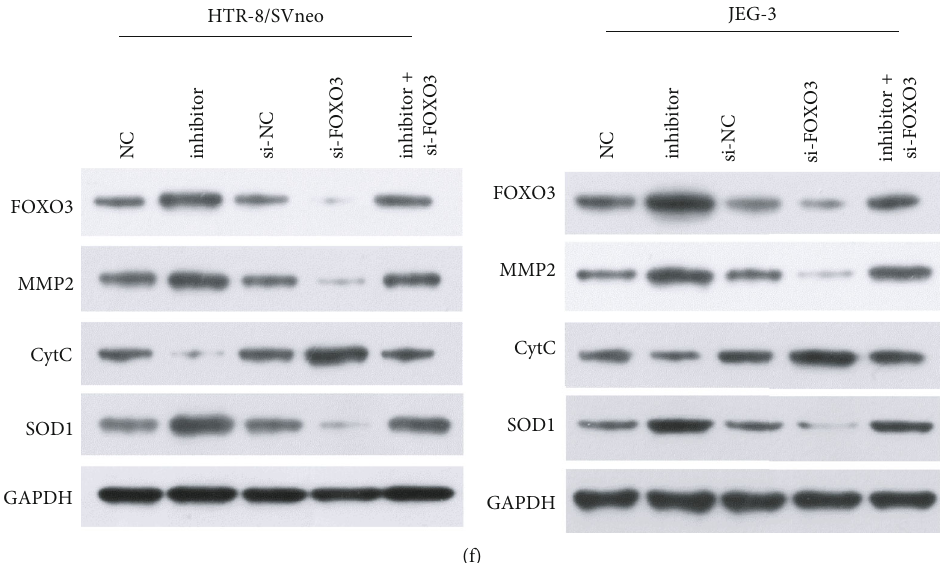
Figure 6: miR-155 knockdown inhibited in fl ammation, apoptosis, and oxidative stress in trophoblast cells by upregulating FOXO3. HTR8/ SVneo and JEG-3 cells were transfected with NC, inhibitor, si-NC, si-FOXO3, and inhibitor + si-FOXO3, respectively. ELISA assay was used to measure the release of (a) IL-6, (b) IL-8, and (c) TNF- α in cell supernatants of the above-transfected cells. (d, e) Expression levels of MMP2 were determined using RT-qPCR assay (d) and ELISA assay (e) in the above-transfected cells. (f) The protein levels of FOXO3, MMP2, CytC, and SOD1 were measured in the above-transfected cells. ∗ P < 0 : 05 , and ∗∗ P < 0 : 01